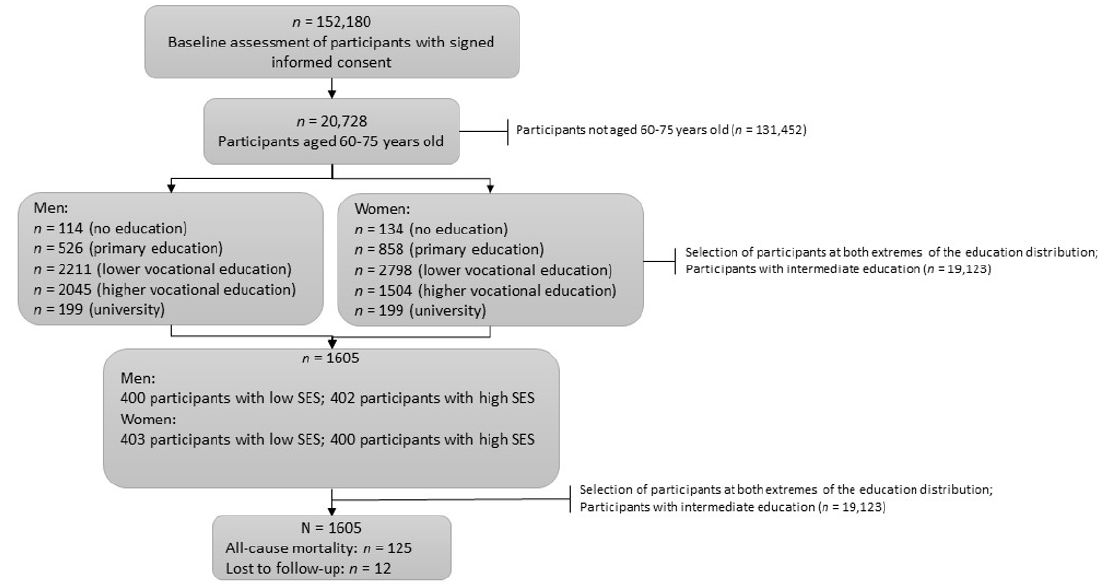
Figure 1. Flow chart of inclusion and exclusion criteria of MINUTHE cohort in this study. Abbrevia- tion: SES, socioeconomic status.